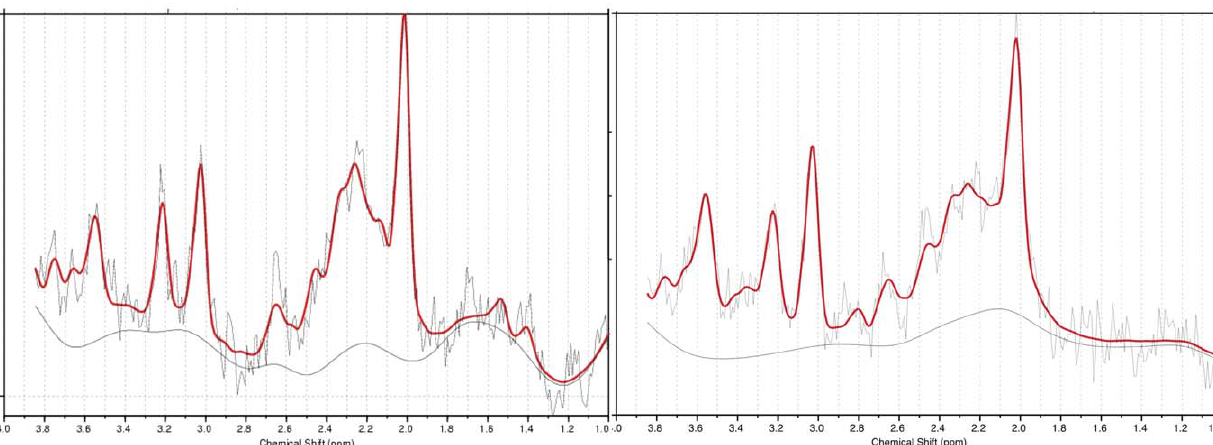
Figure 2. Raw ( lightgray ) , fit ( heavysolidred ) , and baseline ( solidgray ) LCModel ( Provencher 2001 ) output spectra for proton magnetic resonance spectroscopy voxels placed in midline pregenual anterior cingulate ( pACC ) in study subject with ASD ( left ) and control subject ( right ) . Note larger Glx peak (2.0–2.5 ppm) in subject with ASD . Seven of 8 subjects with ASD exhibited Glx levels above the control mean (Fig. 3). Experiment 1.